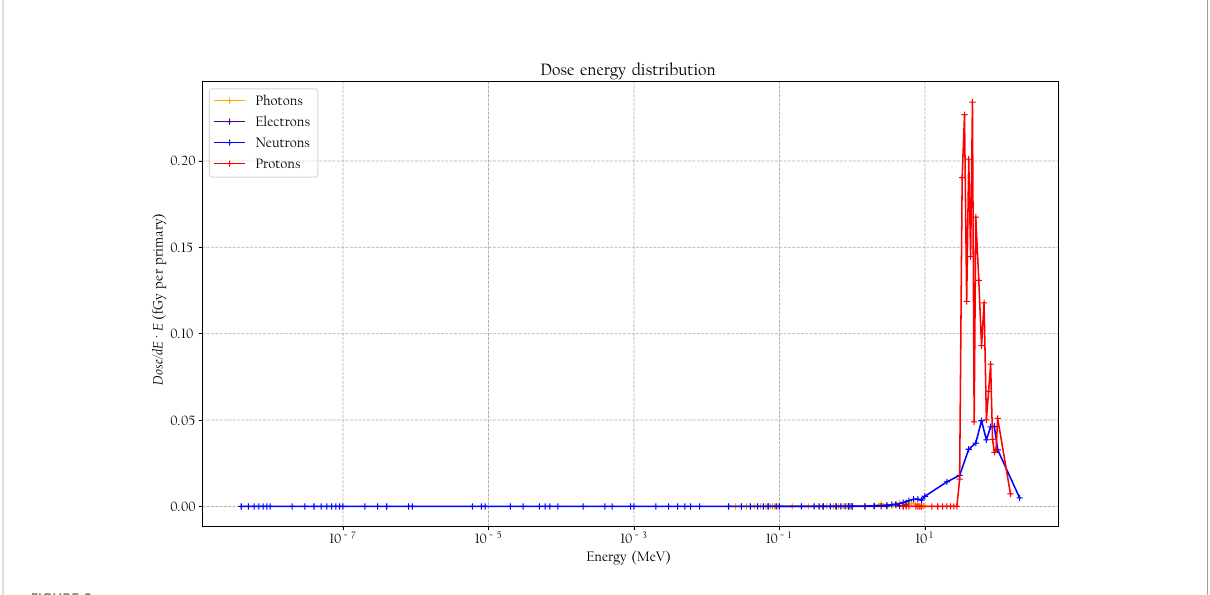
FIGURE 8 The simulated dose distribution at position A when the phantom is irradiated with 146-MeV protons and a range shifter is applied with a 23-cm air gap.